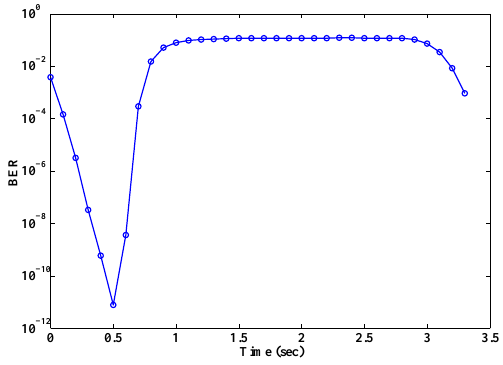
Figure 4: BER during one respiration